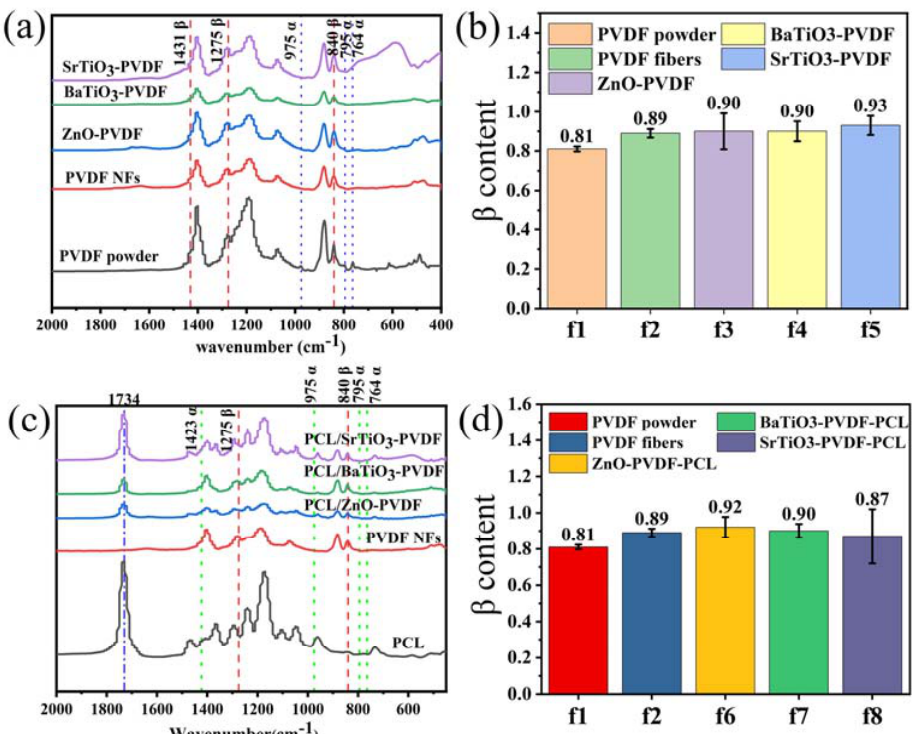
Figure 5. The FT-IR spectra and β content. ( a ) FT-IR spectra of PVDF with added piezoelectric nanoparticles. ( b ) β content of PVDF with added piezoelectric nanoparticles. ( c ) FT-IR spectra of core- sheath fi bers with added piezoelectric nanoparticles. ( d ) β content of core-sheath fi bers with added piezoelectric nanoparticles.